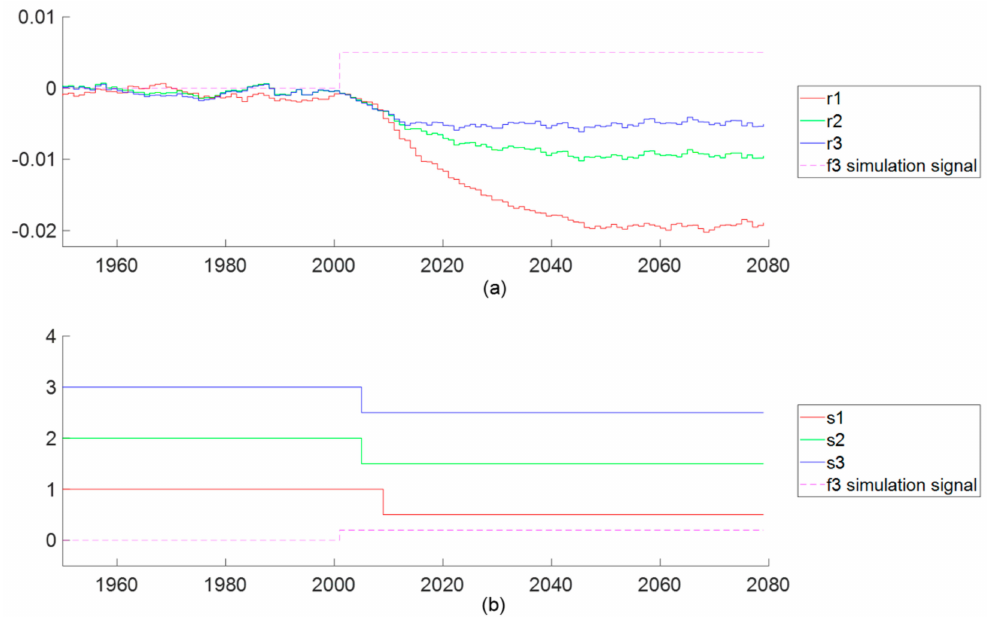
Figure 6. Examples of diagnosing in case of f 3 fault: ( a ) residual values and simulated fault indicator; ( b ) diagnostic signal values (scaled to (cid:104)− 0.5, 0.5 (cid:105) and shifted to s j